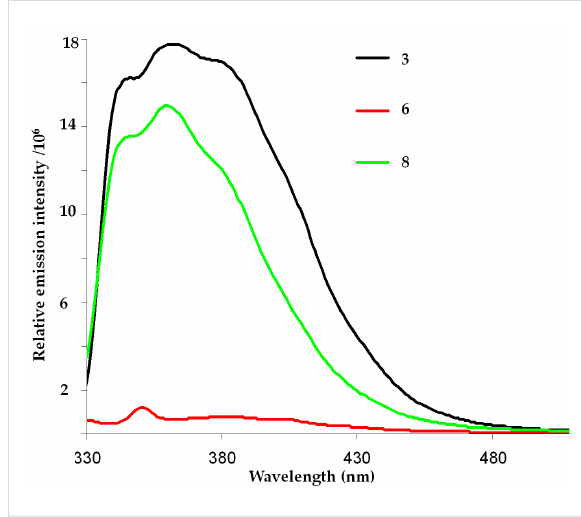
Figure 4: Room temperature emission spectra for 10 µM solutions of 4-ethyl-4′-ethylstilbene ( 3 ) in the capsule 1.1 ( 6 ) and 1.7 4 .1 ( 8 ). λ exc = 318